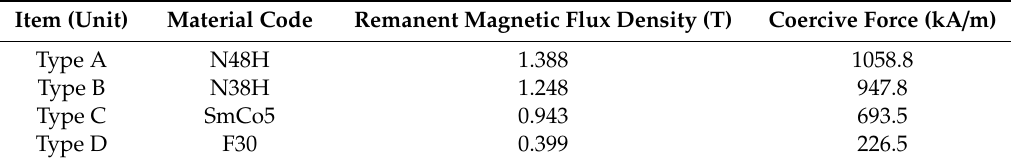
Table 1. Specification of tested PMs.